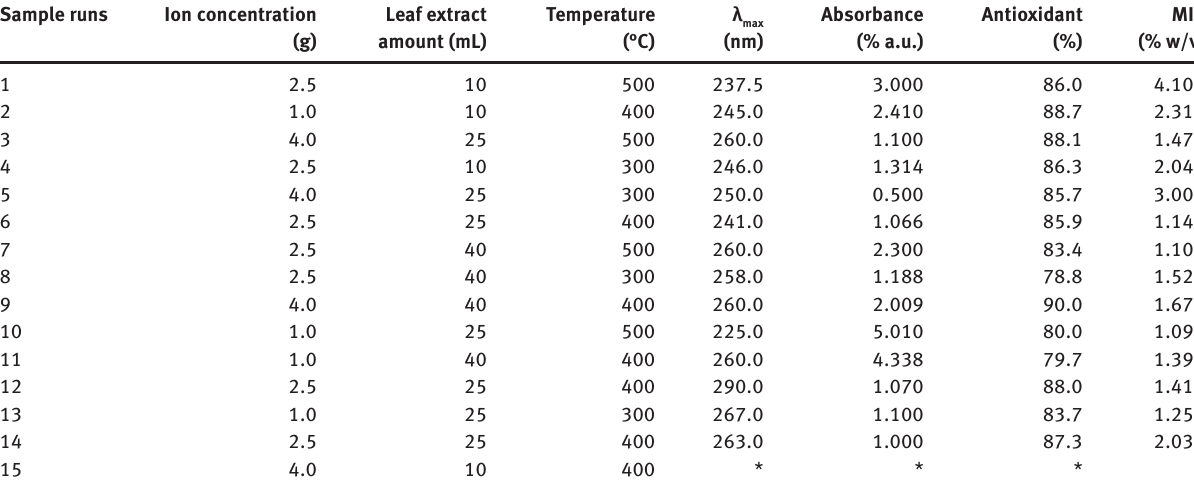
Table 1: Box behnken design and response variables for synthesis of CuO NPs using walnut leaf extract. Sample runs